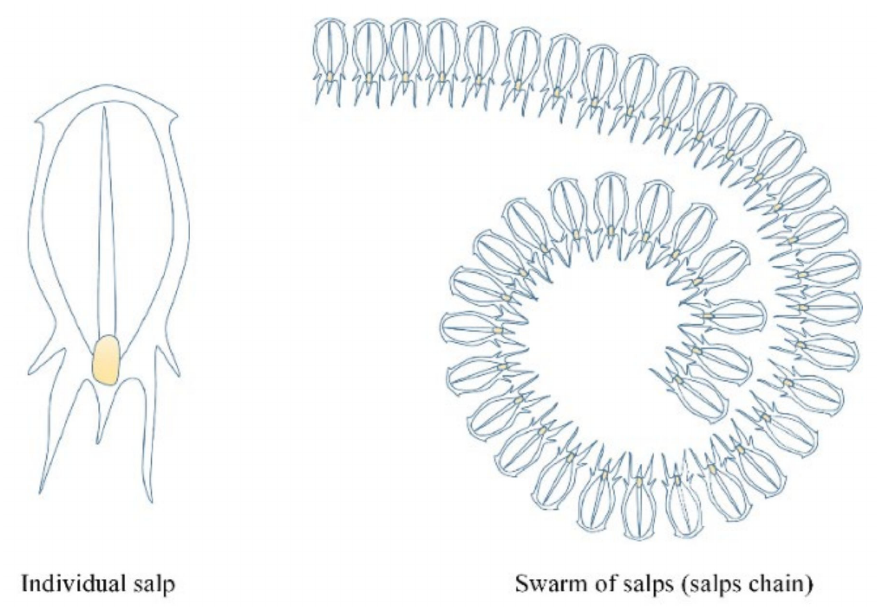
Figure 1. Individual salp and swarm of